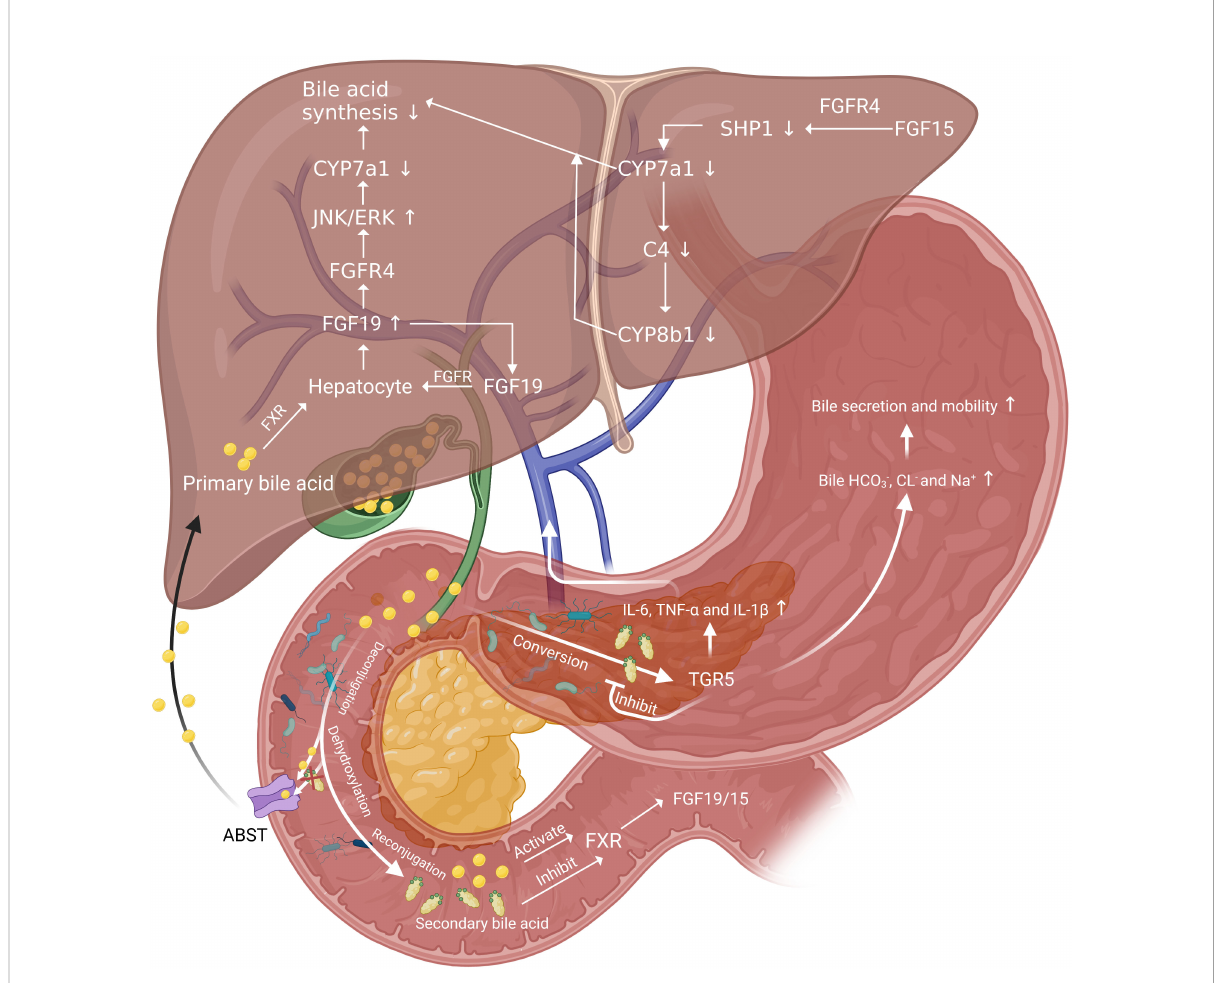
FIGURE 2 The role of gut microbiota in BAs related negative and positive regulation pathways of liver regeneration. FGF19 inhibit the rate-limiting enzyme for the synthesis of BAs, CYP7a1 and thus down-regulate BAs synthesis. And there is a positive feedback regulation of FGF19 by acting on FGFR on hepatocytes. BAs released into the intestine by the gallbladder act on FXR on intestinal epithelial cells and induce the release of FGF19 and FGF19. Then FGF19 reach liver through portal vein and function in the same way. FGF15 bond with FGFR4 to increase SHP1 expression in hepatocytes and decrease the level of CYP7a1 and CYP8b1. Secondary BAs converted from primary BAs by gut microbiota can inhibit FXR and activate TGR5, secreting in fl ammatory cytokines. These cytokines can be collected by portal vein and function to delay liver regeneration. The activation of TGR5 can also increase the bile secretion and mobility to reduce BAs overload in